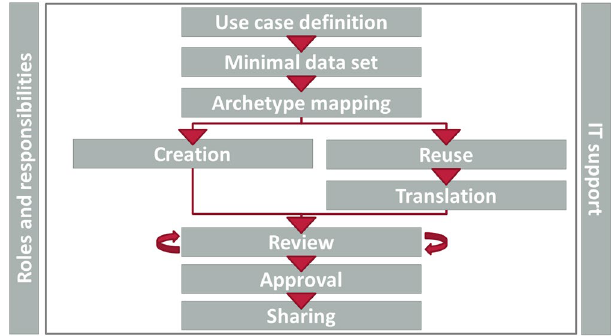
Figure 1. Clinical Knowledge Governance in HiGHmed (core modelling